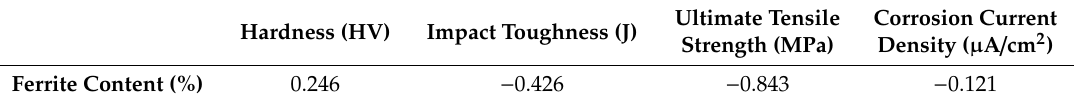
Table 15. Pearson correlation coe ffi cient between ferrite content and properties of duplex stainless steel.